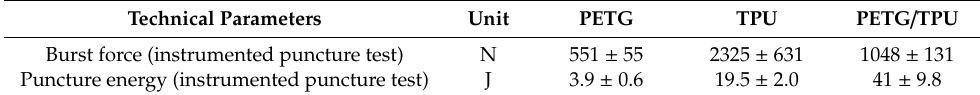
Table 1. Mechanical characteristics [7].